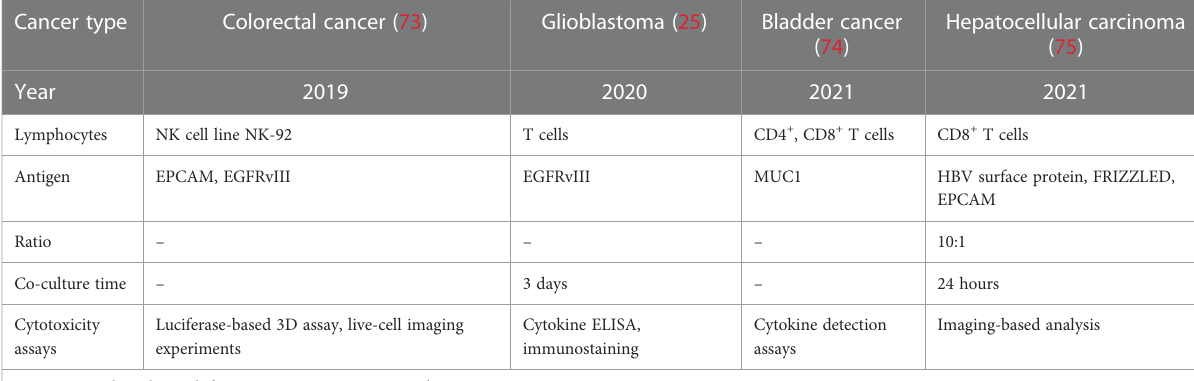
TABLE 3 Co-culture modeling systems of cancer OGs with CAR-engineered